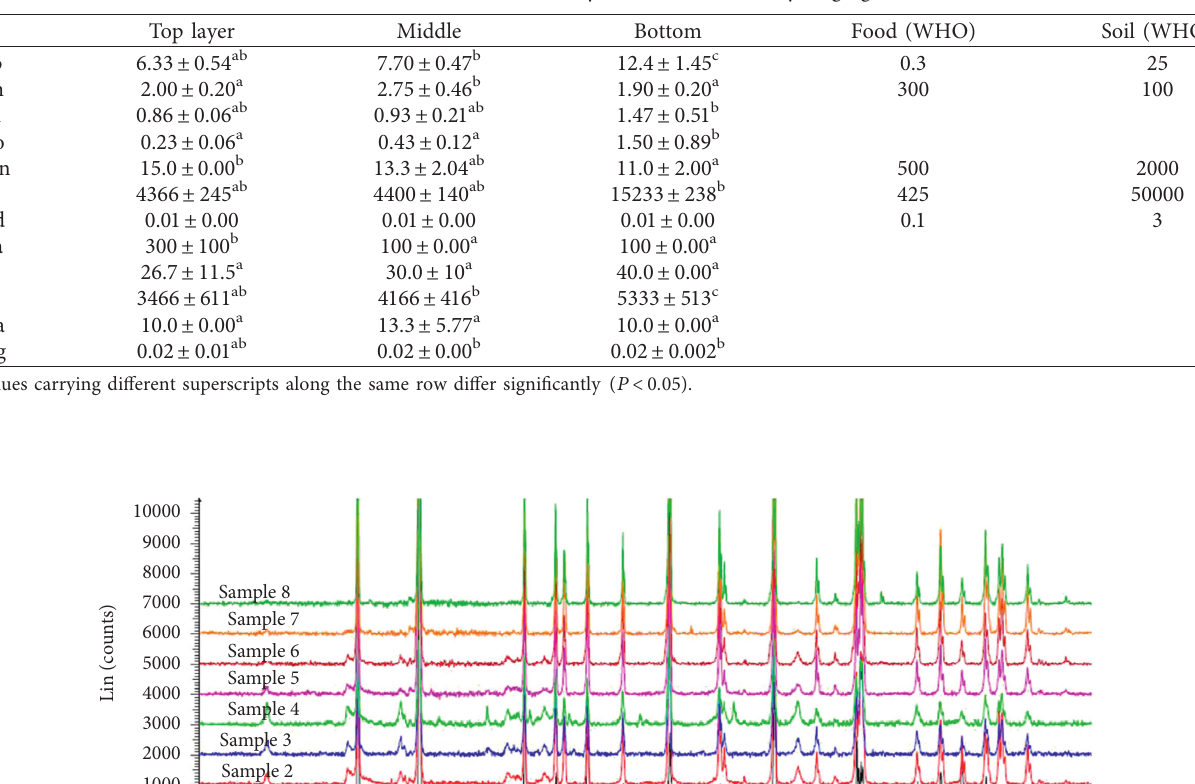
Table 1: Results of metal analysis of the studied clay (mg/kg).